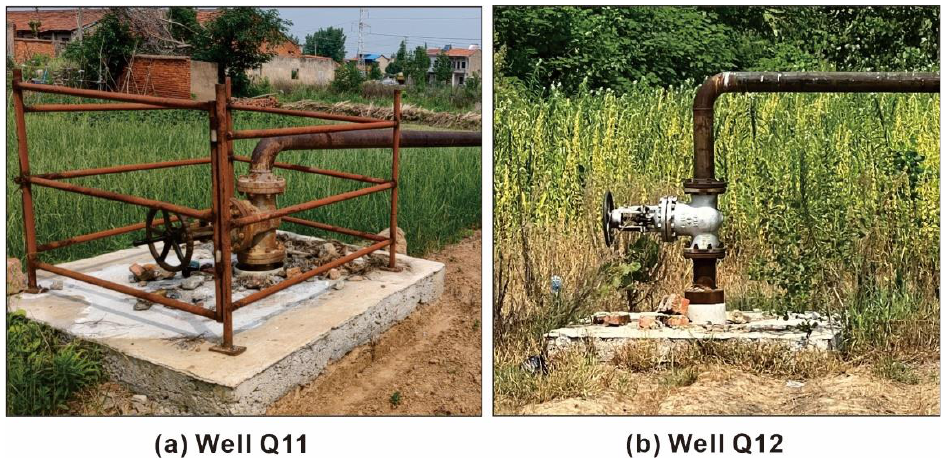
Figure 10. Site photos of Q11 – Q12 well group.